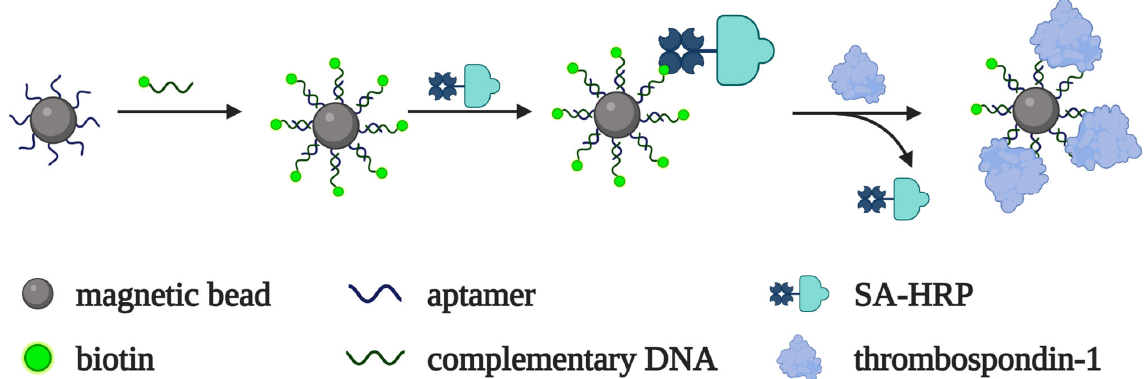
Figure 9. Aptamer-based system for thrombospondin-1 detection developed by K. Ji et al. [54]. The aptamer on magnetic beads forms a duplex with biotinylated DNA that binds the streptavidin–HRP conjugate. HRP oxidizes the chromogenic substrate and generates a colorimetric signal. Throbmospondin-1 displaces biotinylated DNA from the complex with the bead-bound aptamer. The peroxidase conjugate cannot bind with the beads, which leads to a decrease in the colorimetric signal